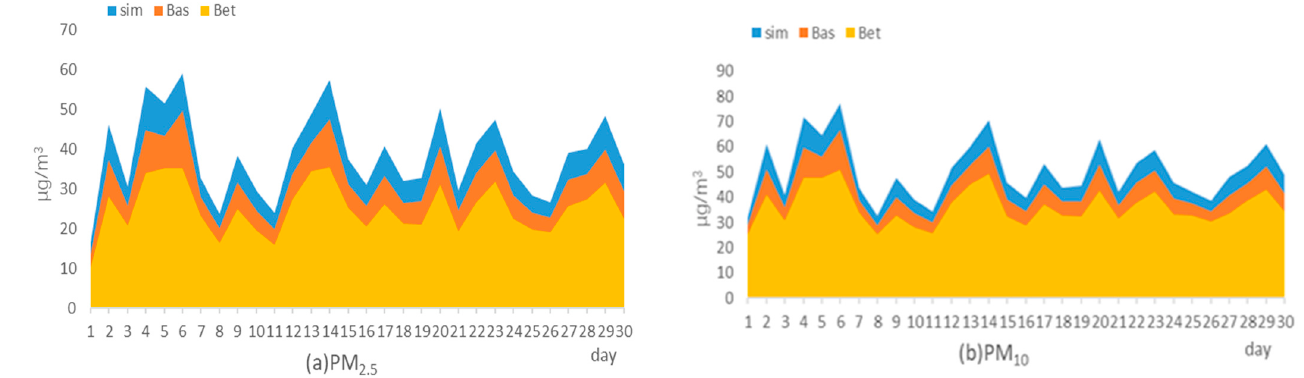
Figure 9. Variation chart of daily average of Bozhou PM 2.5 and PM 10 emission reduction scenarios and simulations in January 2017.